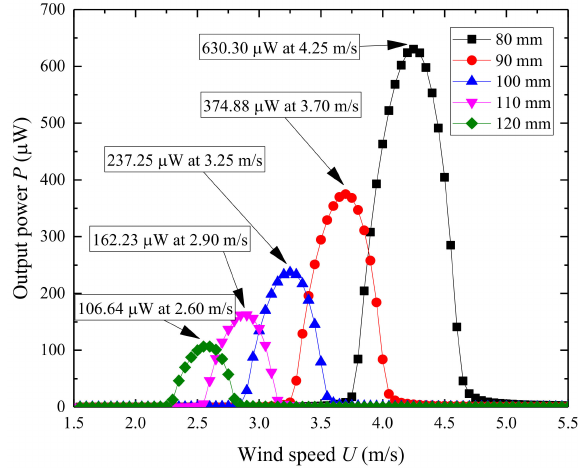
Figure 9. Variation of the first natural frequency and electromechanical coupling coefficient of UPEH as a function of the length of substrate layer.